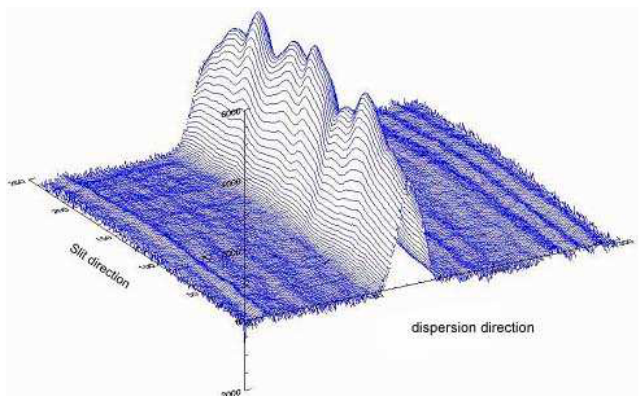
Fig. 3. Three-dimensional display of the distribution of the Fe XIV emission line profiles along the slit, after removing the background and hair lines and averaging five spectra. Note the variations in the central intensities. The slit was put at an average height of 1.5 0 from the east limb.